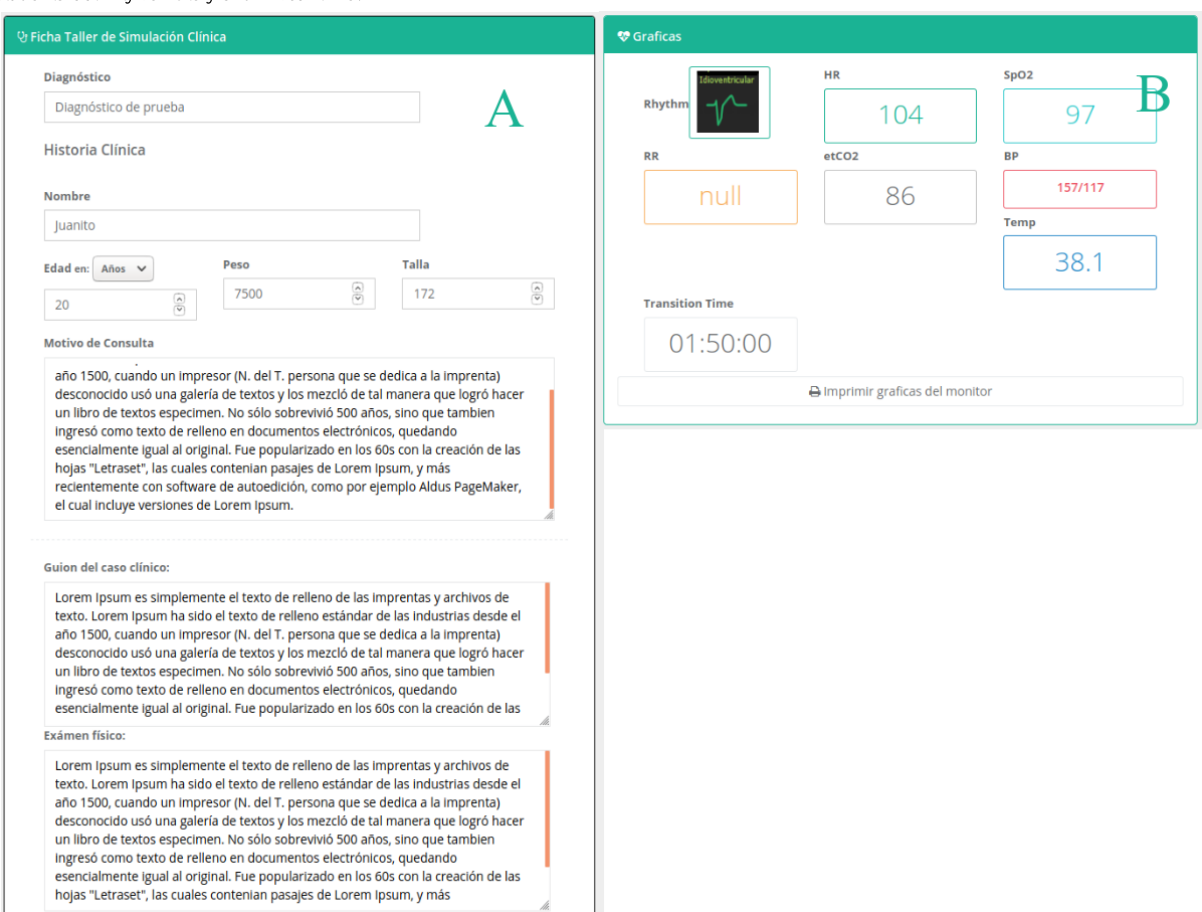
Figure 6. Students’collaborative design module. (A) and (B) are the views of the web platform's graphical interface. (A) shows a view of the students' case design form, where the designer group enters information to support their case design. (B) shows a teacher's view from where he or she can monitor the students' activity remotely and in real